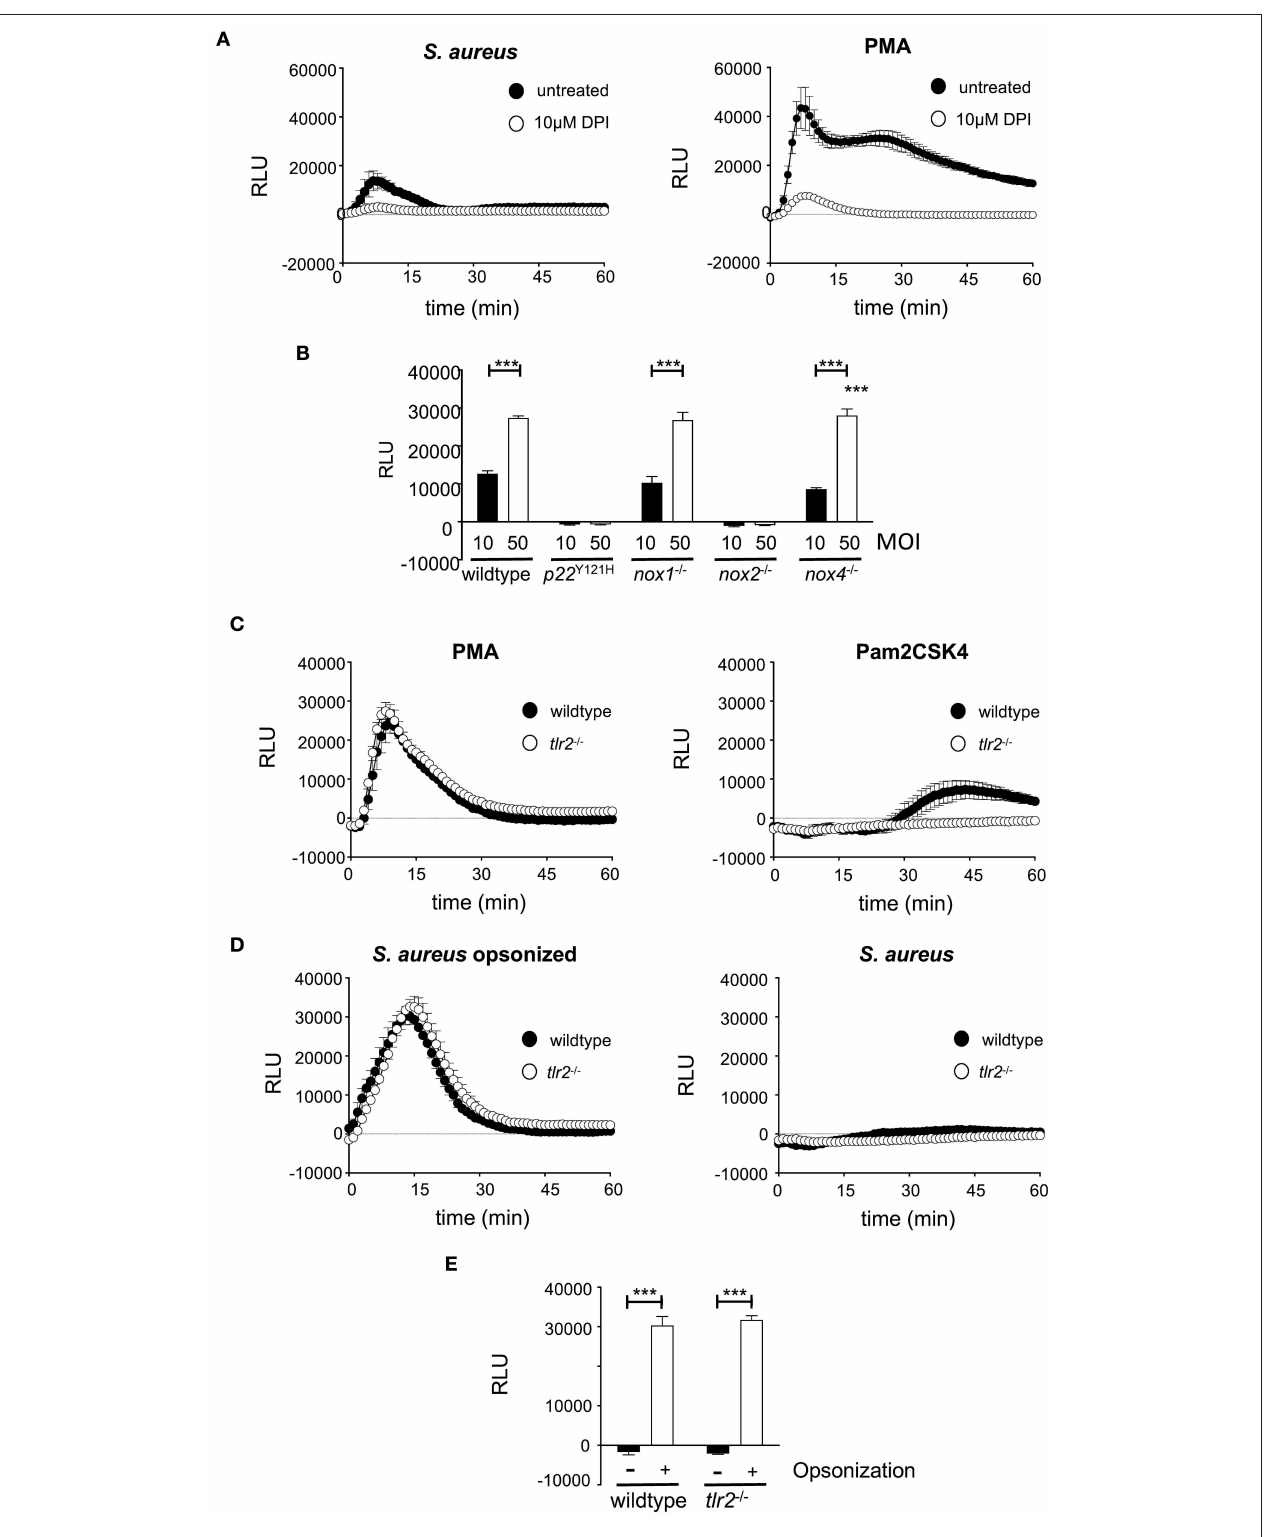
FIGURE 1 | Opsonophagocytosis of S. aureus leads to NOX2 dependent ROS production in macrophages. For ROS measurement, 1 × 10 5 wildtype or knockout BMDM were seeded in a white 96-well plate without antibiotics 16h prior to measurement. ROS production was measured using Luminol in a Luminometer preheated to 37 ◦ C. (A) ROS production in wildtype BMDM incubated with opsonized S. aureus (MOI50; left) or 10 µ M PMA (right) in the absence (closed circles) or presence of